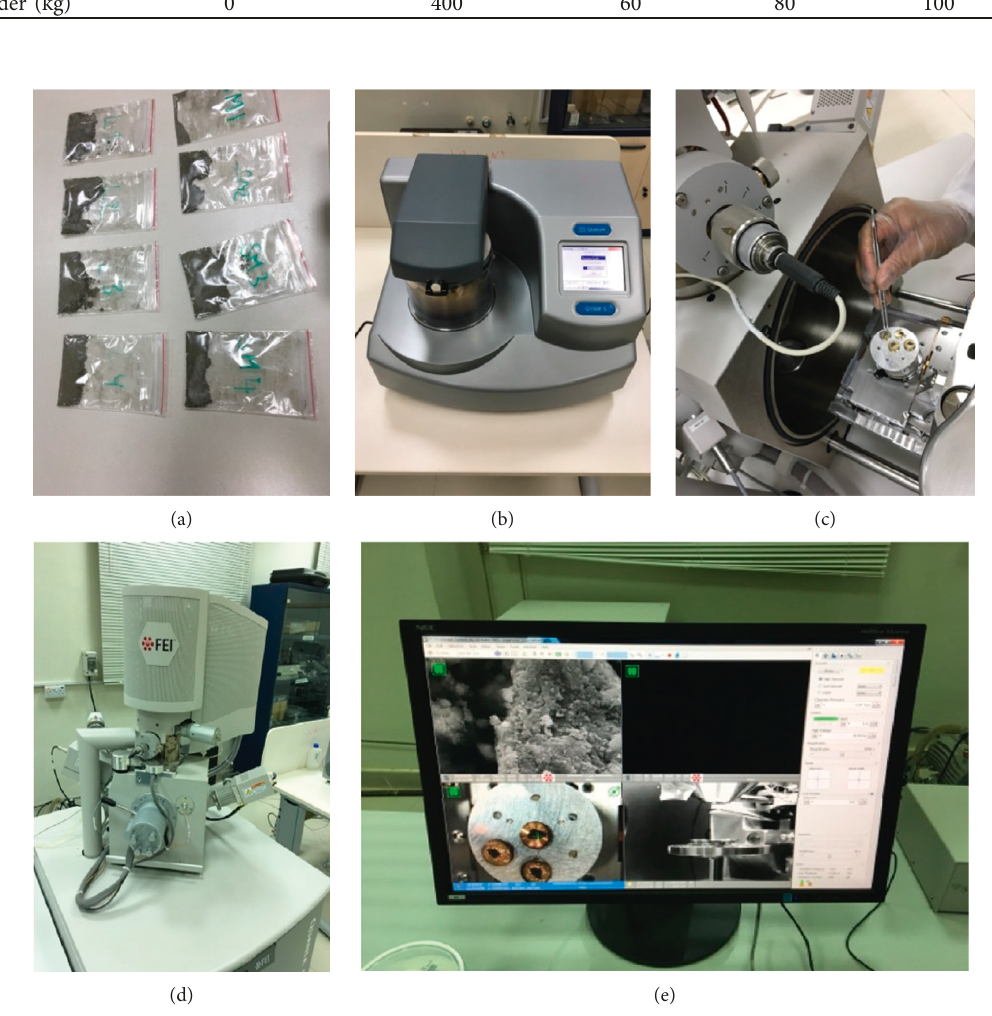
Figure 6: The scanning electron microscope (SEM).